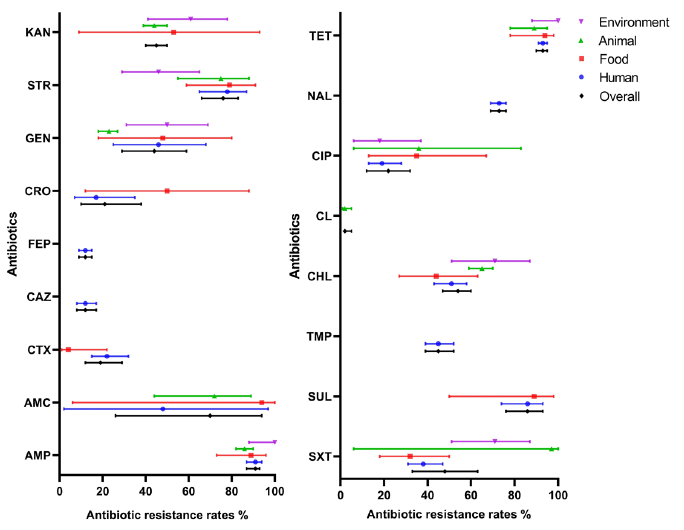
Figure 3. Resistance rate of S . 1,4,[5],12:i:- to antibiotics by sampling sources. Antibiotics in the left picture: AMP, ampicillin; AMC, amoxicillin–clavulanic acid; CTX, cefotaxime; CAZ, ceftazidime; FEP, cefepime; CRO, ceftriaxone; GEN, gentamicin; STR, streptomycin; KAN, kanamycin. Antibiotics in the right picture: SXT, trimethoprim–sulfamethoxazole; SUL, sulfisoxazole; TMP, trimethoprim; CHL, chloramphenicol; CL, colistin; CIP, ciprofloxacin; NAL, nalidixic acid; TET, tetracycline. Lines indicate 95% confidence